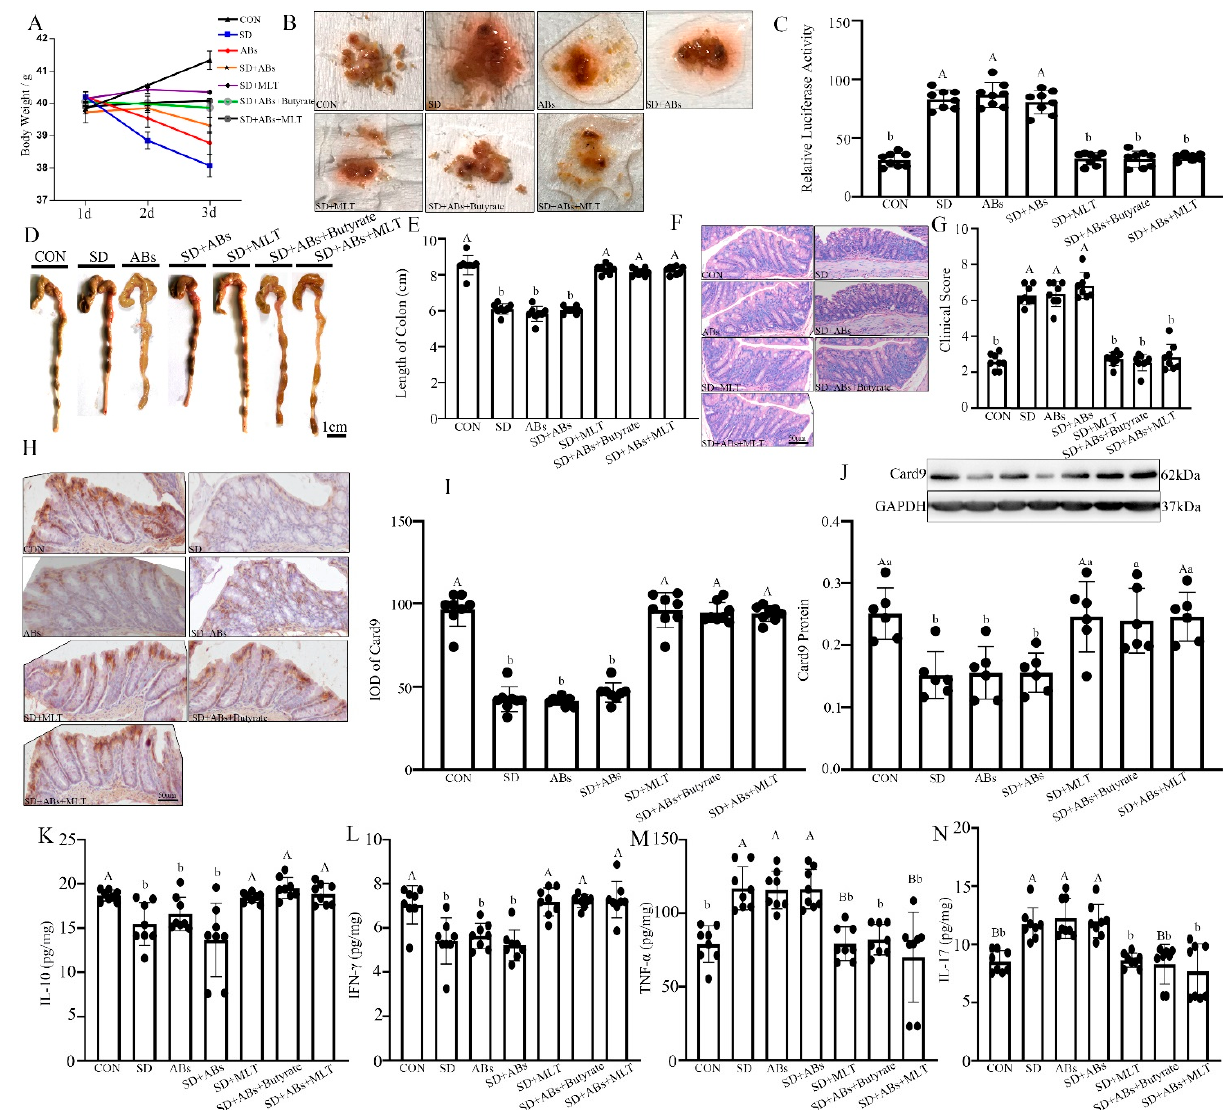
Figure 5. Effect of melatonin and butyrate supplementation on improving SD-induced colitis in mice. ( A ) Body weight; ( B ) fecal occult blood; ( C ) relative luciferase activity for colonic permeability; ( D , E ) colonic length; ( E , F , H ) staining photographs (scale: 50 µ m); ( G ) histopathological score; ( H ) immunohistochemical staining photographs of Card9 (scale: 50 µ m); ( I ) integral optical density (IOD) of Card9-positive cells; ( J ) relative protein level of Card9; ( K – N ): IL-10 ( K ), IFN- γ ( L ), TNF- α ( M ), IL-17 ( N ) concentrations in the colon of the CON, SD, ABs, Abs + SD, SD + MLT, Abs + SD + Butyrate, and Abs + SD + MLT groups ( n = 9). Values are presented as the mean ± SE. Differences were assessed using ANOVA and are denoted as follows: different lowercase letters: p < 0.05; different uppercase letters: p < 0.01; same letter: p >